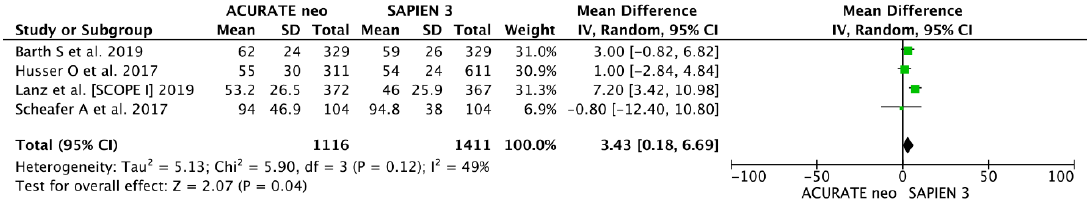
Figure A4. Procedural outcomes. Detailed analysis of individual weighted mean di ff erences (MDs) with corresponding 95% CIs on procedure duration for the comparison of ACURATE neo vs. SAPIEN 3. (4) 3.4. Clinical